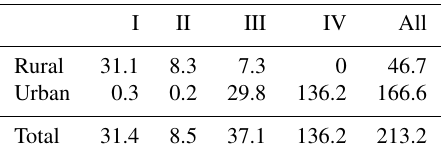
Table 7. Expected annual damage (in million USD in 2016 values) to building structures by vulnerability class in urban and rural areas of Ethiopia. I II III IV All Rural 31.1 8.3 7.3 0 46.7 Urban 0.3 0.2 29.8 136.2 166.6